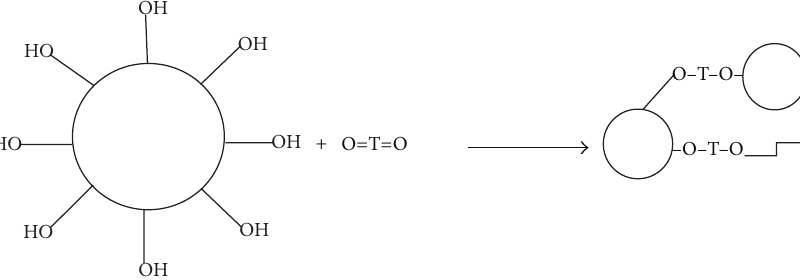
Figure 1: Schematic illustration of the reaction between titanium oxide and the hydroxyl groups of nanoalumina.